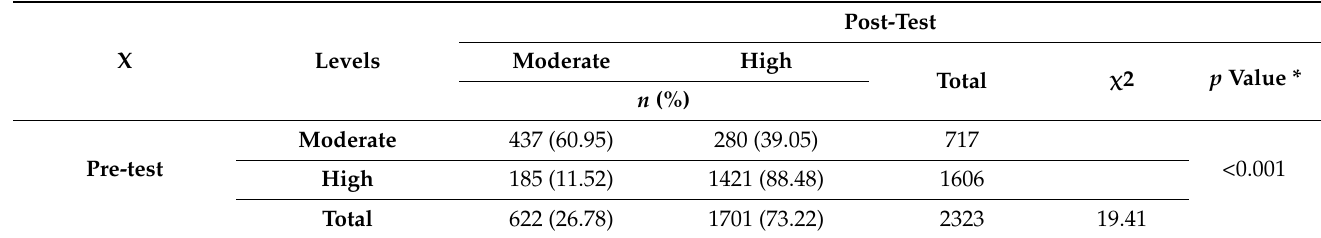
Table 4. Change in life skill levels (categories) pre- and post-training ( n = 2323).